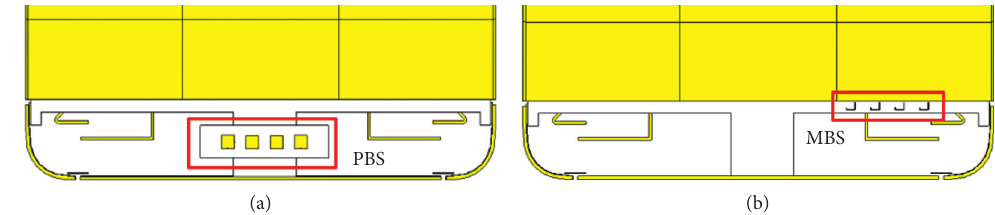
Figure 4: Array implementation in the mobile phone’s form factor (plastic casing hidden for better visualization): (a) PBS; (b) MBS.